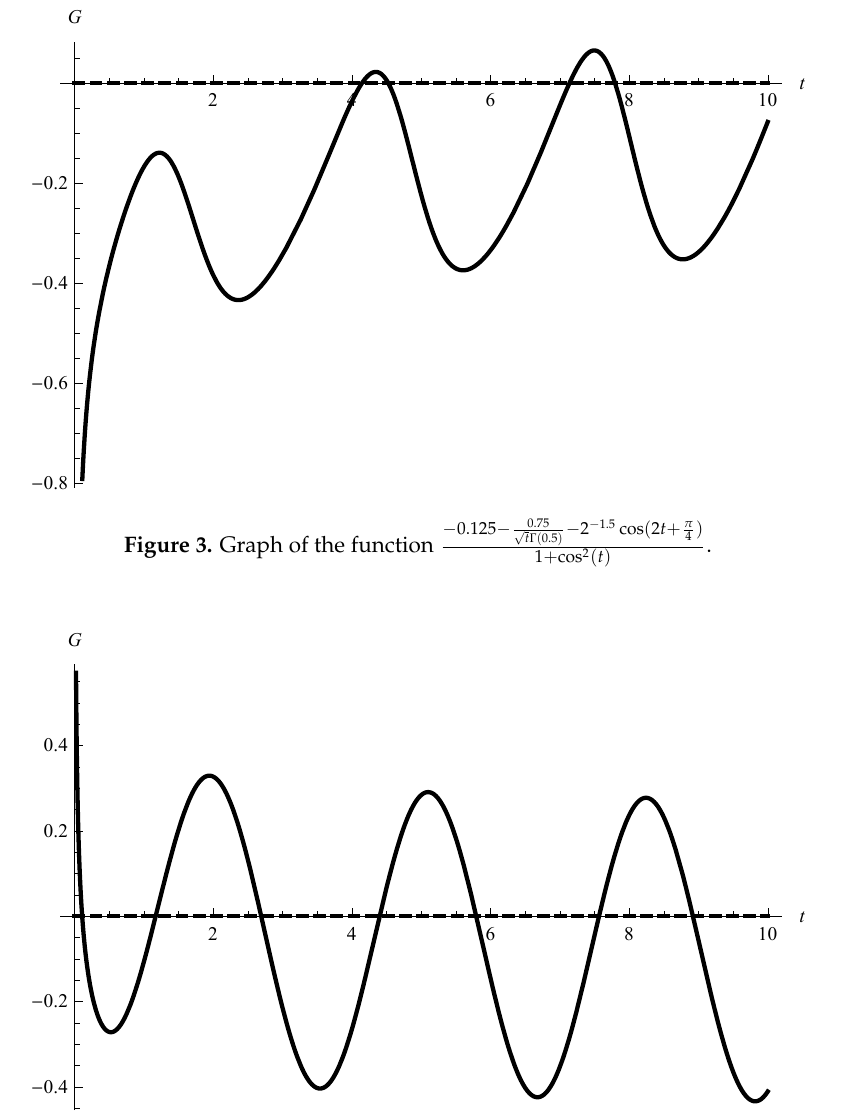
Figure 4. Example 5. Graph of the function g ( t )